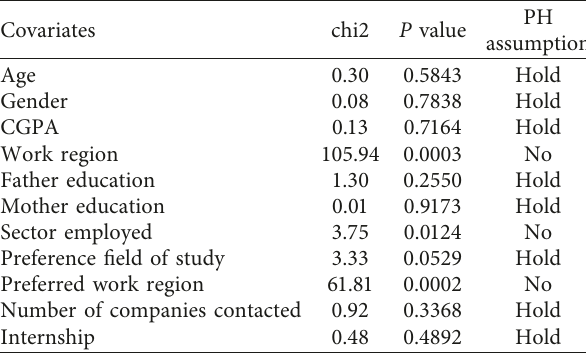
Table 6: Proportional hazard assumption checking results.